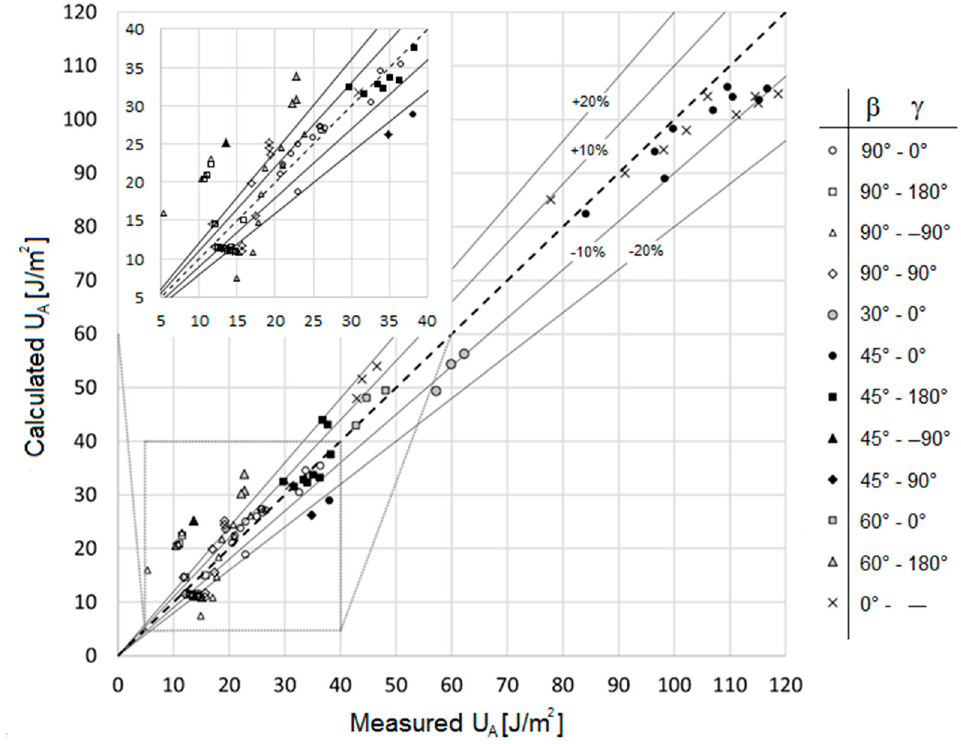
Figure 4. Comparison between measured and calculated Erythemal UV irradiance for the three sites. Int. J. Environ. Res. Public Health 2019 , 16 , x